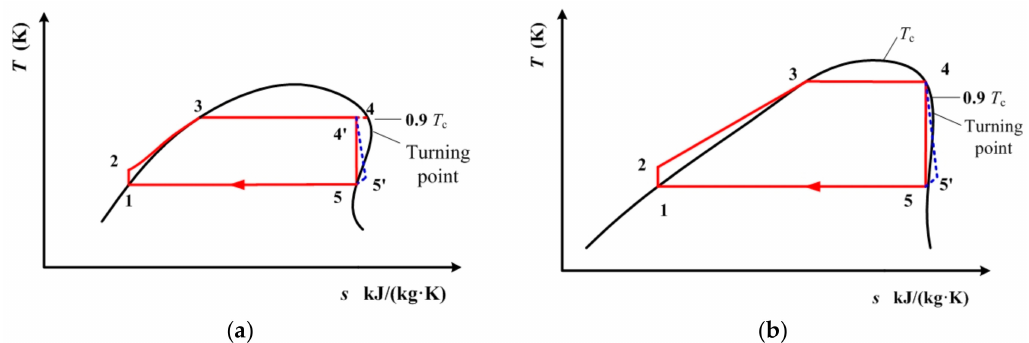
Figure 14. ( a ) Subcritical and ( b ) transcritical cycles of R1234yf and R1234ze(E) when considering the isentropic e ffi ciency of the expander.